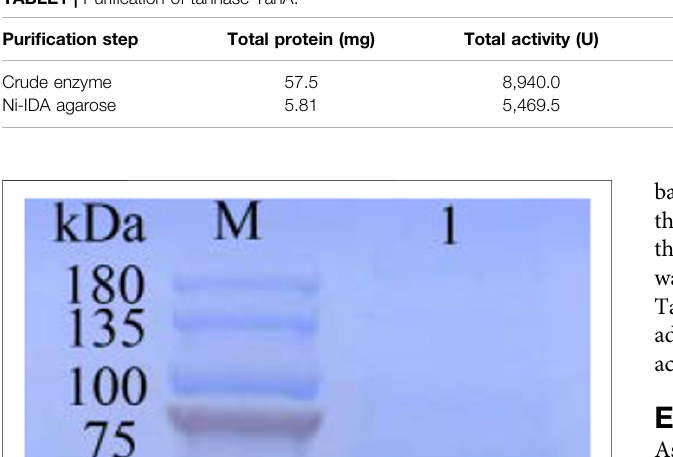
Frontiers in Bioengineering and Biotechnology |